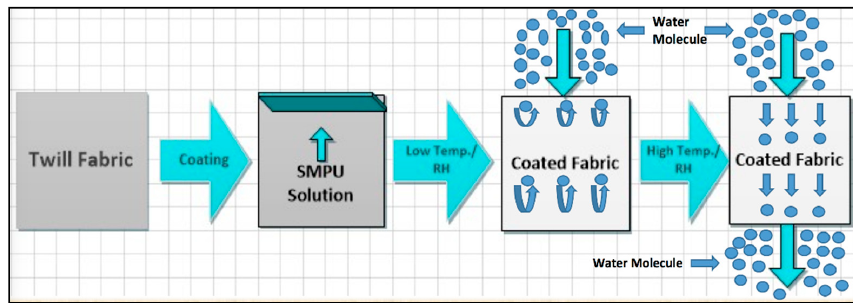
Figure 2. Theoretical approach of fabric coating and water vapor transmission.